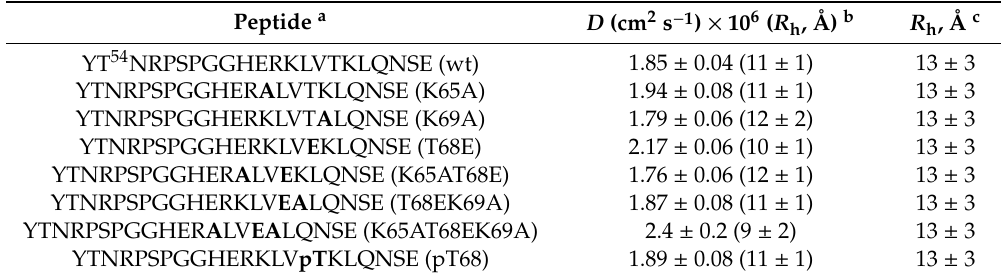
Table 1. Hydrodynamic properties of the nuclear localization sequence (NLS) NUPR1 peptides. Peptide